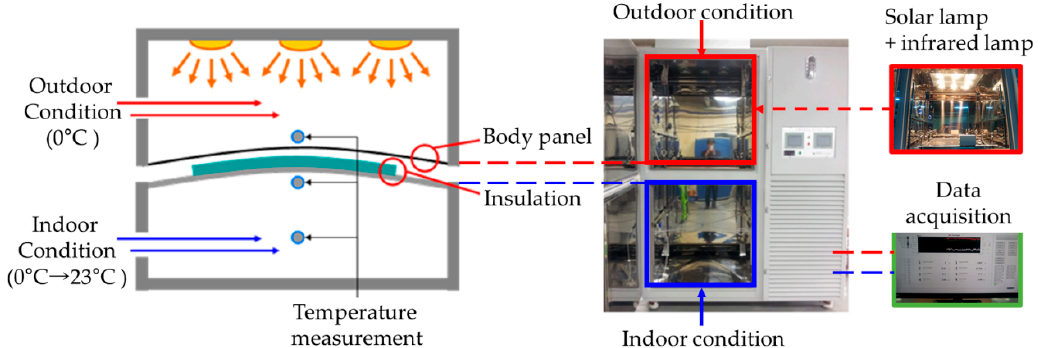
Figure 11. Configuration of headliner insulation performance evaluation facility.